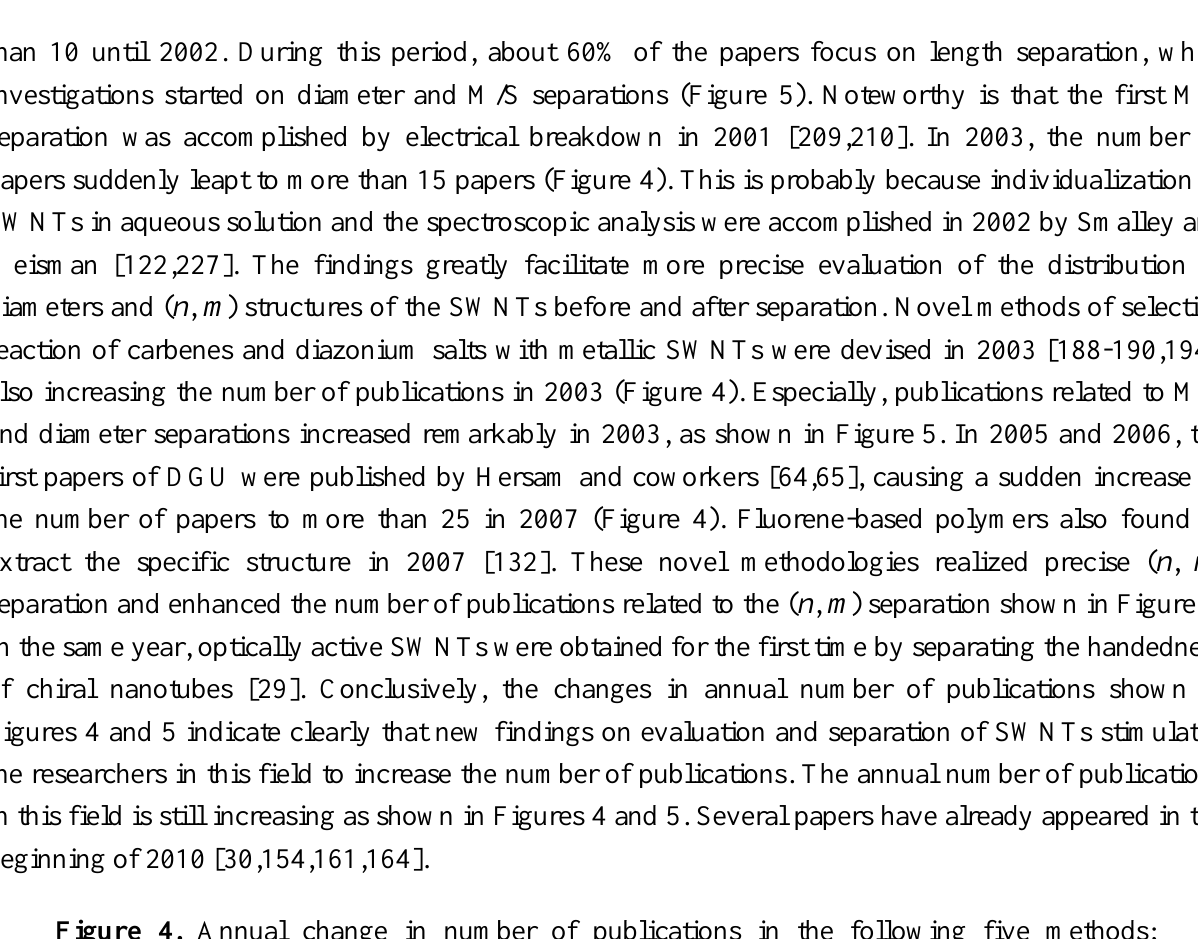
Figure 4. Annual change in number of publications in the following five methods; electrophoresis (3-1), centrifugation (3-2), chromatography (4-1), selective solubilization (4-2) and selective reaction